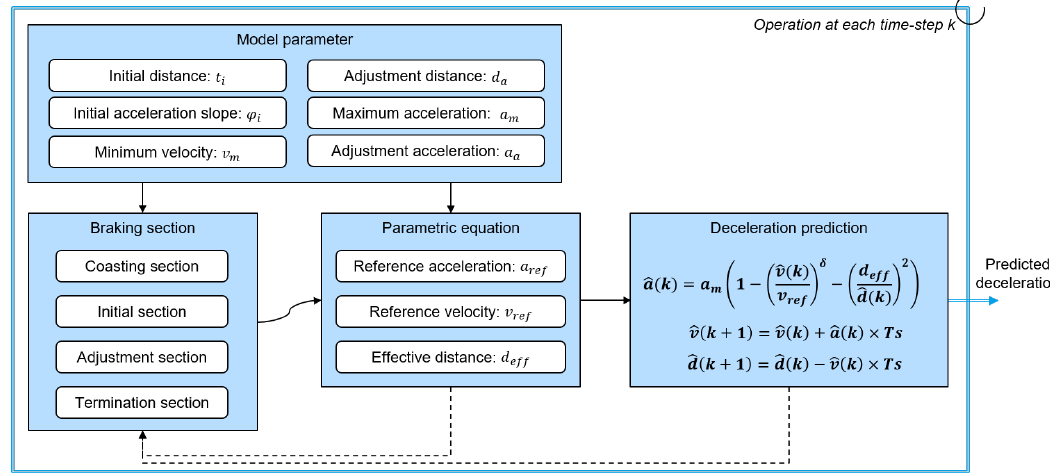
Figure 6. Diagram of the acceleration profile prediction